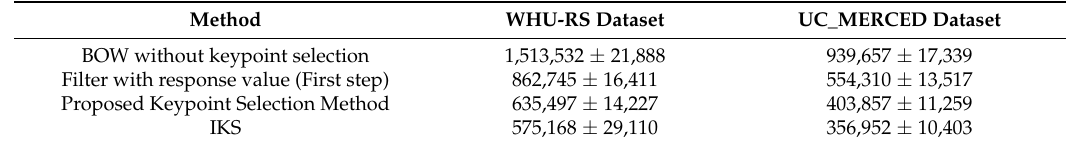
Table 1. Number of average remaining keypoints in our method and IKS and their standard deviation.